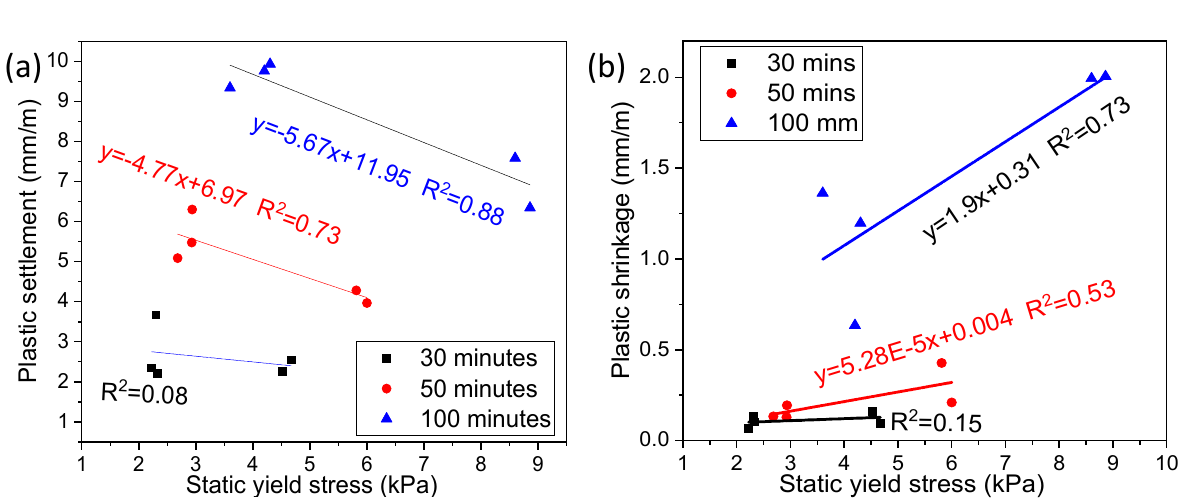
Figure 12. Relationship between the increasing static yield stress and (a) plastic settlement (b) plastic